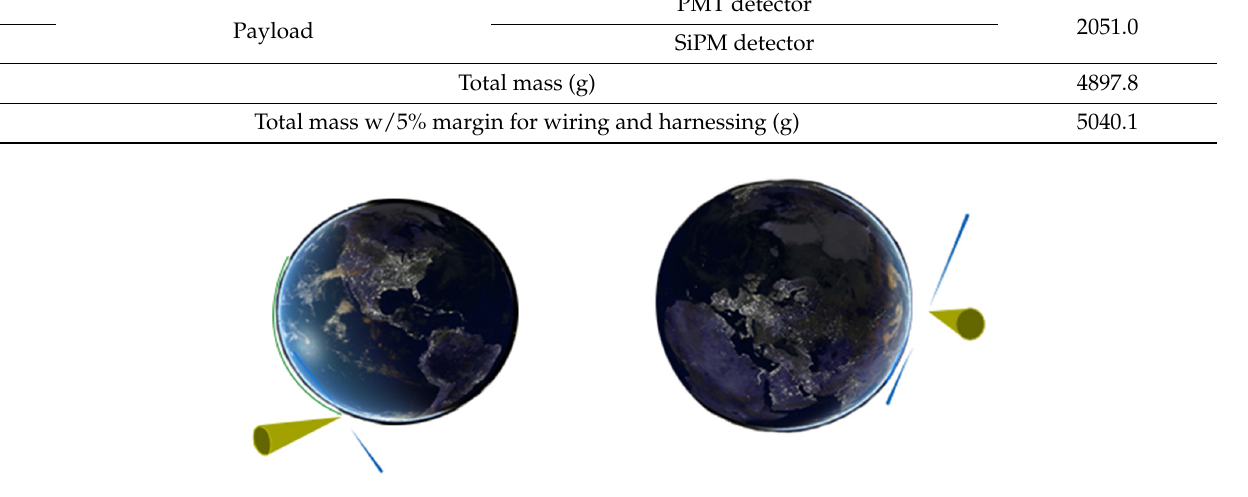
Figure 8. Light-1 Sun horizon pointing